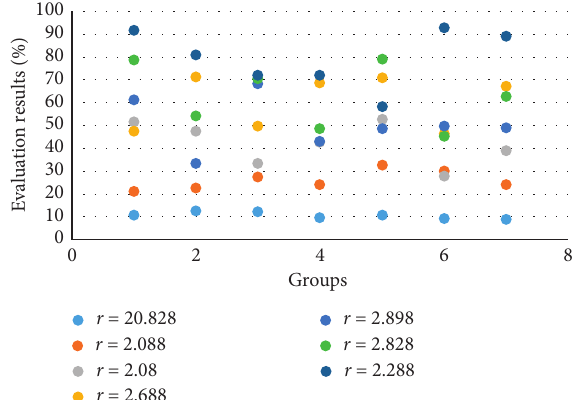
Figure 4: Evaluation results of model